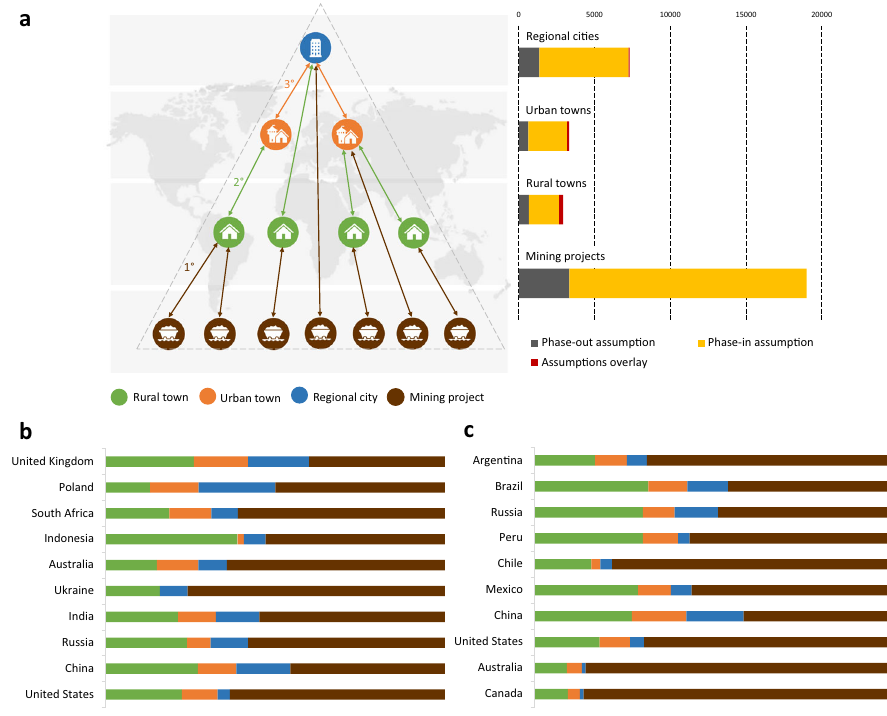
Fig. 5 | Global exposure to the coal phase-out and ETM phase-in assumptions carried in thethreeresource inventories.a Number of regionalcities, urbanand rural towns and mining projects in global mine-town systems. b Top 10 countries withthe highest exposureto the coalphase-out assumption, i.e. countries withthe